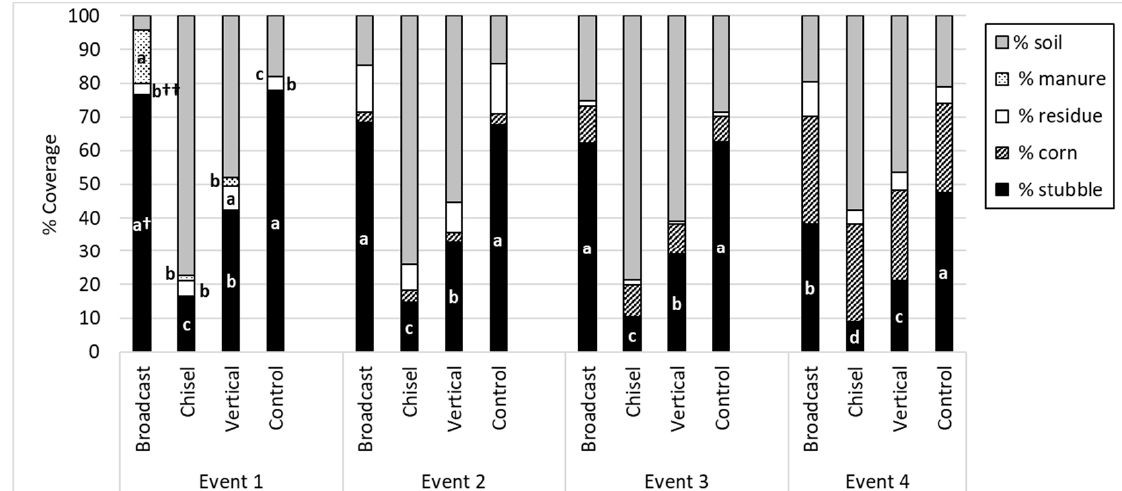
Figure 2. Average plot surface coverage (%) by treatment for soil, manure, residue, corn, and tritcale stubble. † values with the same letter are not significantly different at p ≤ 0.1. †† letters to the right of the bar represent % residue differences and letters to the left represent % manure differences.